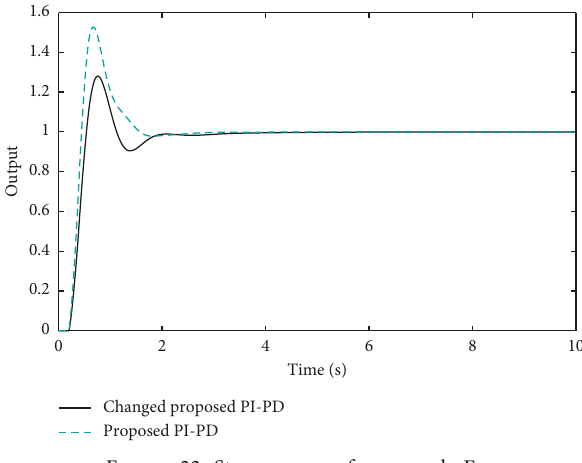
Figure 22: Step response for example